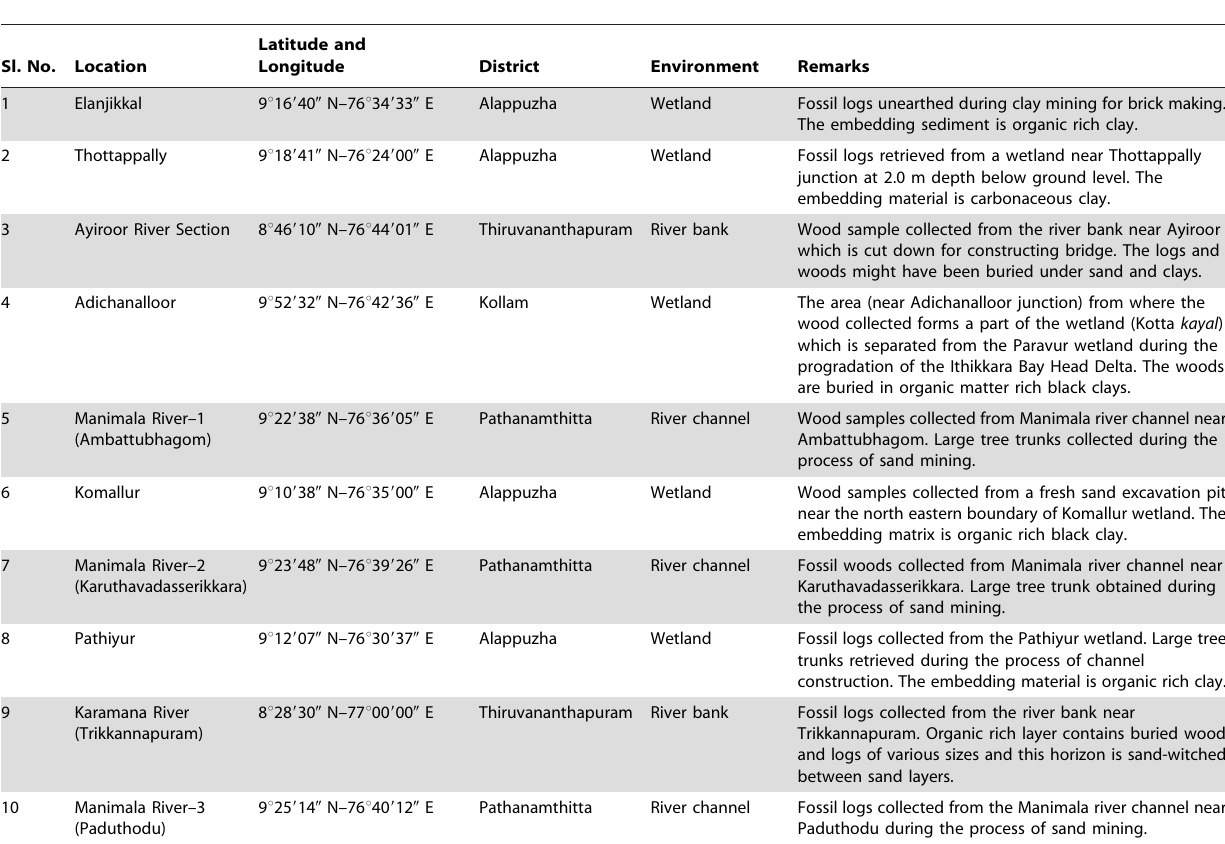
Table 1. Location of wood samples along with their environment and details of sample collection.